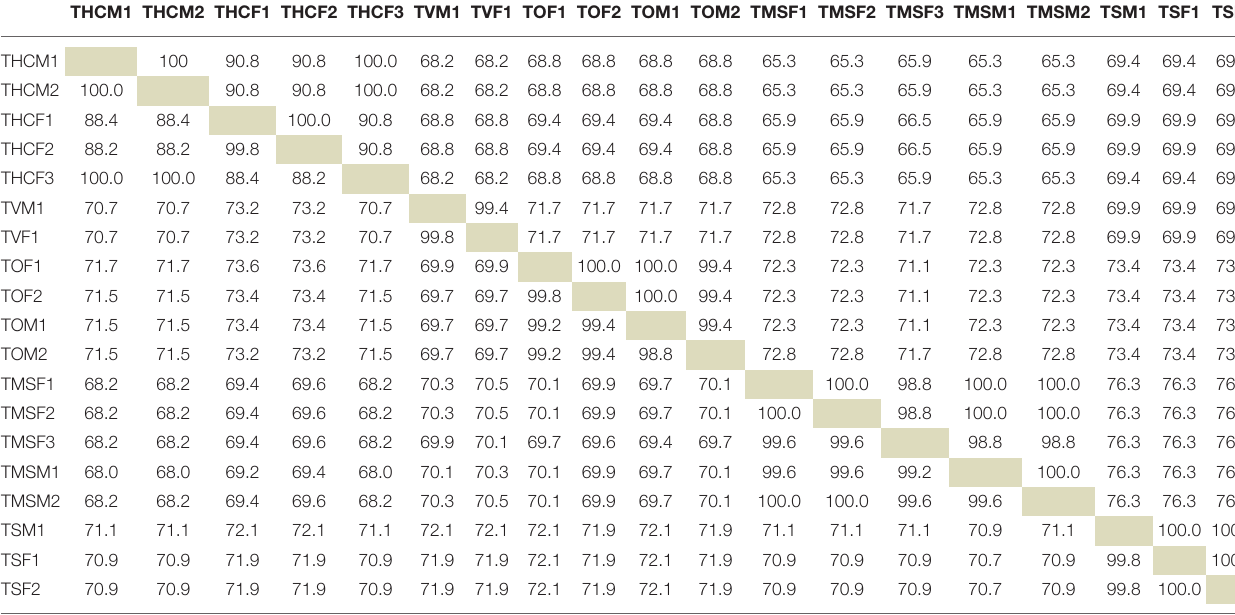
TABLE 4 | Pairwise nucleotide and amino acid distances for the cytochrome b partial gene sequences for Trichuris species studied in this work.